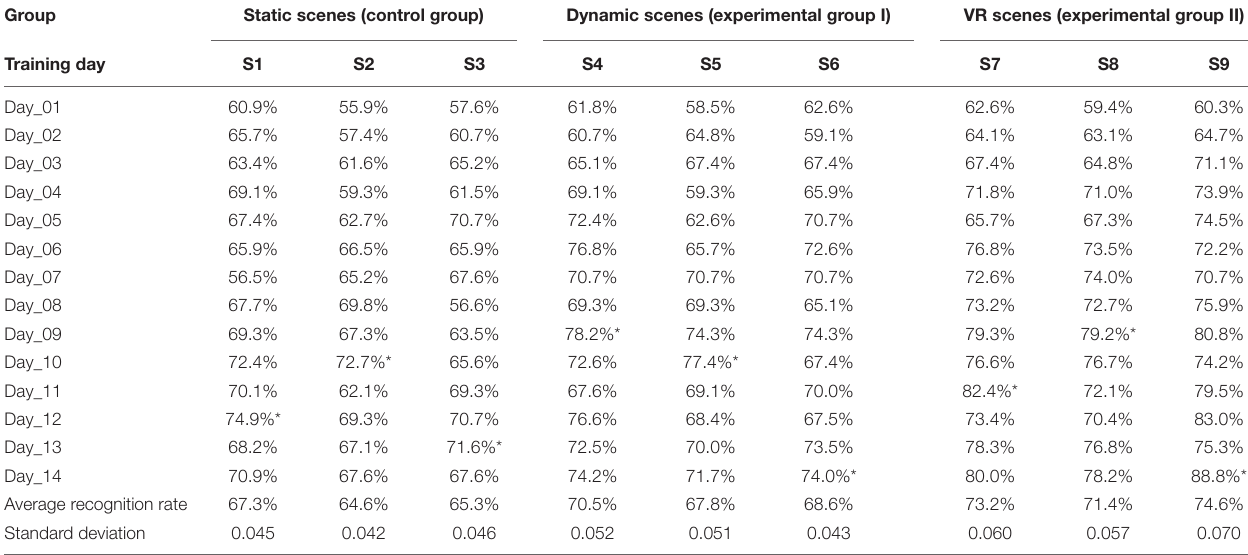
TABLE 1 | Statistical results of online recognition rate during MI training in different virtual scenes (%). Group Static scenes (control group) Dynamic scenes (experimental group I) VR scenes (experimental group II)